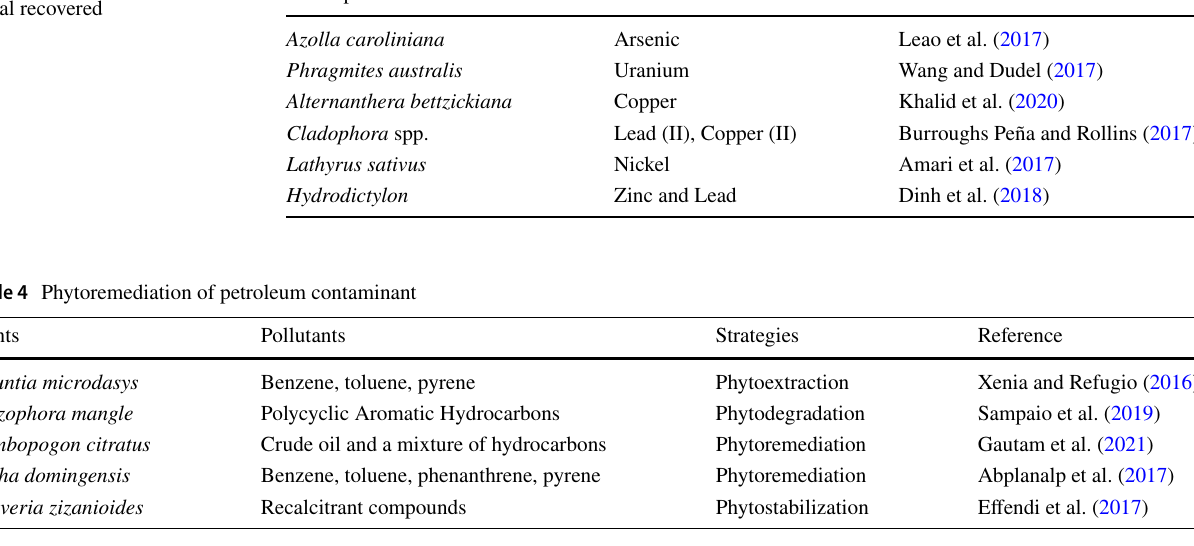
Table 3 Phytoremediation and metal recovered